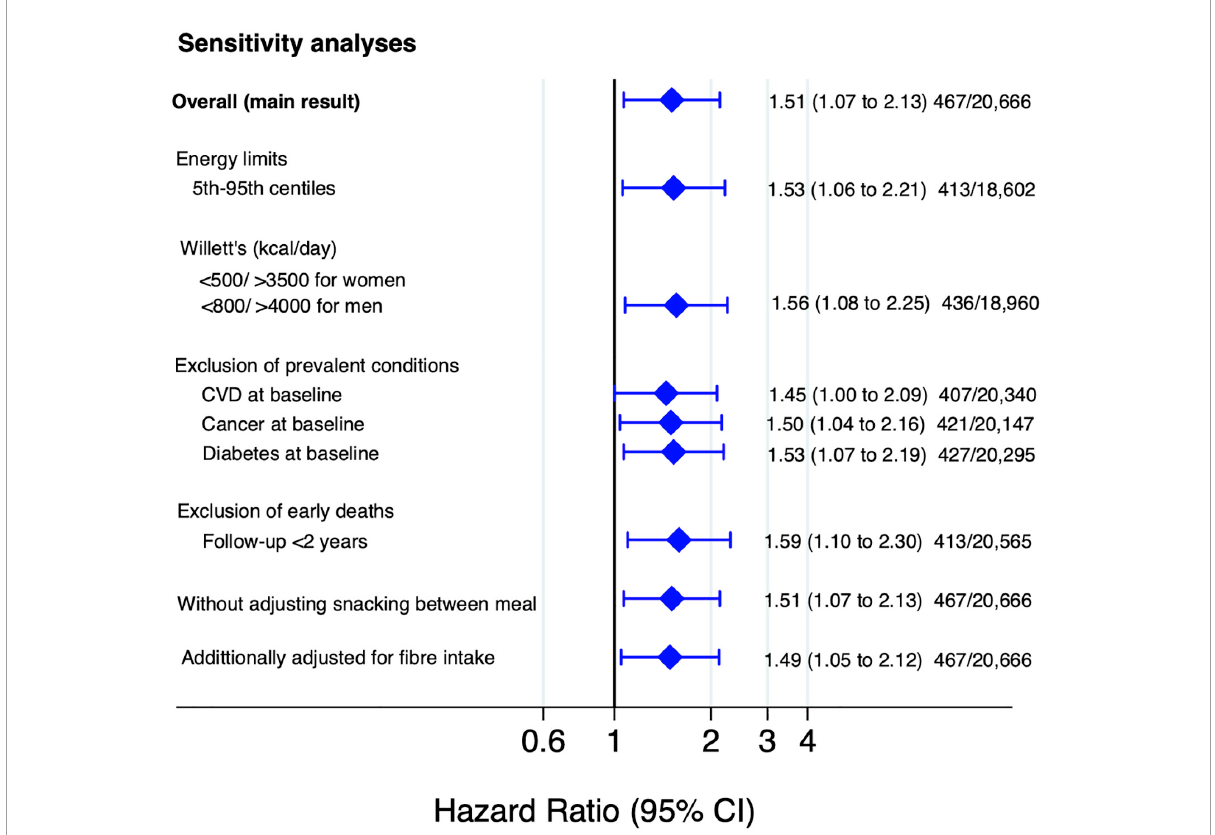
FIGURE4 Sensitivity analyses for the association between Chilean warning label score and all-cause mortality (multivariable-adjusted HR and 95% CI for the highest vs. lowest quartile).